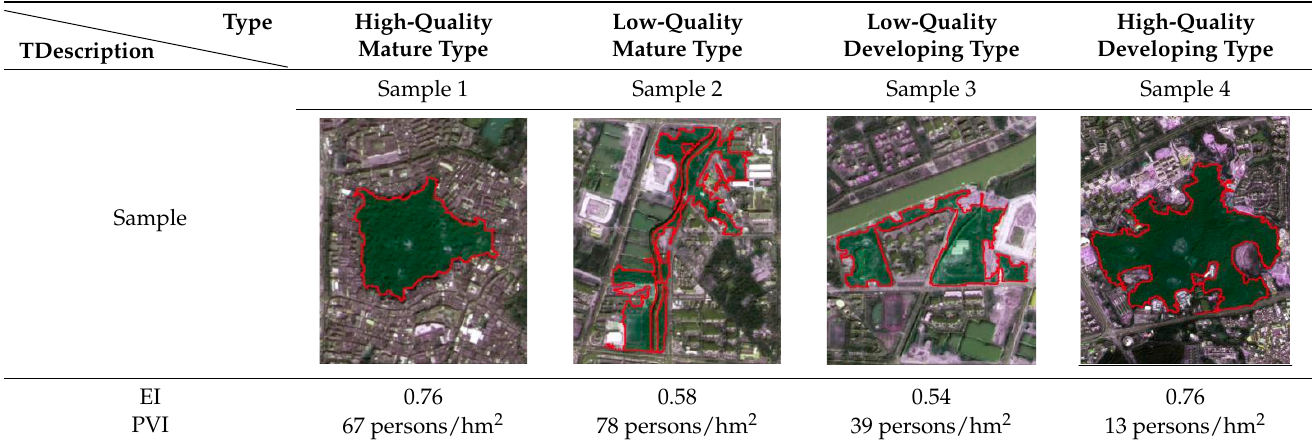
Table 16. Four types of UGI samples.